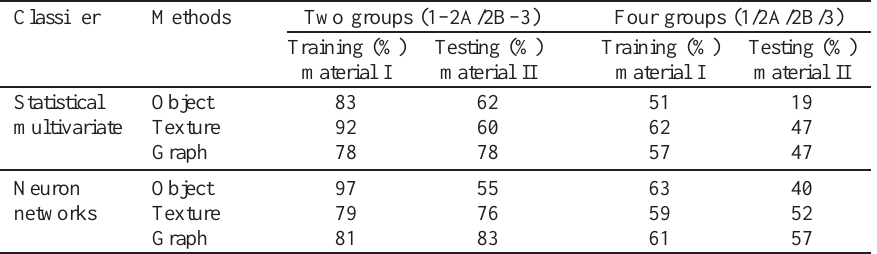
Table 1 Reproducibility for the two independent materials and image analysis systems. Two different classification strategies and three feature extraction methods were analyzed. The percentages express the fraction of correctly classified cases